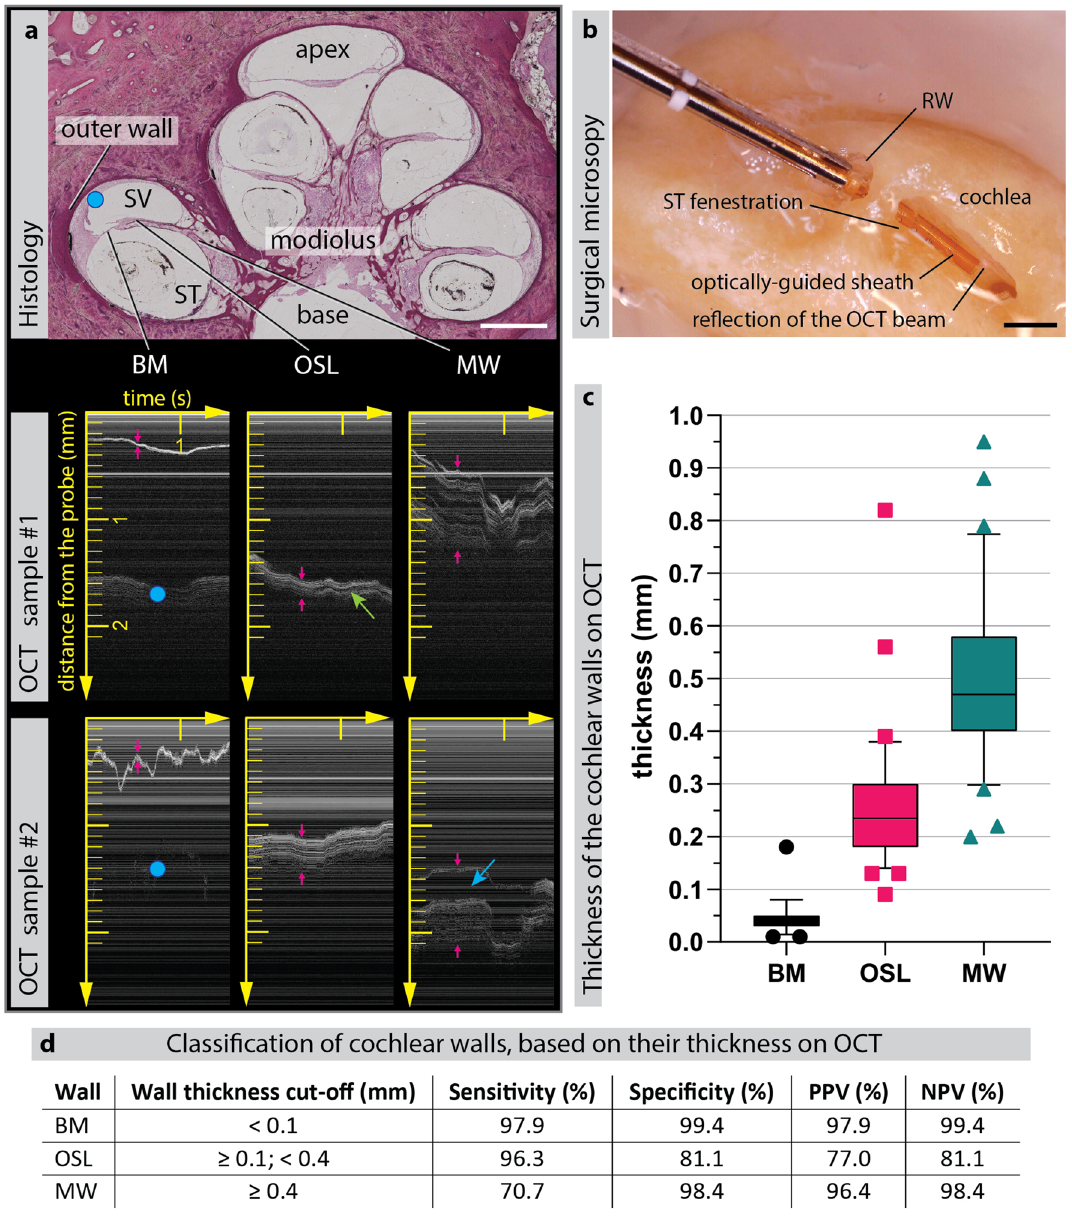
Figure 2. Thickness-based identification of the cochlear walls with the optically-guided sheath. ( a ) Histological section of a human cochlea is provided to illustrate the imaged cochlear walls, with indication of the cochlear apex, base, modiolus, the cochlear compartments (scala vestibuli and scala tympani) and the outer wall. Below, representative OCT M-scans of the BM, OSL and MW in samples #1 and #2 are shown, which were acquired by means of optically-guided sheath. The top of each OCT image corresponds to the position of the probe tip. Each OCT A-scan acquisition corresponds to a column of the OCT image, with a sequence of A-scans (M-scan) acquired over time as the probe is inserted and displayed left to right. The horizontal axis shows time in seconds (most recent A-scans appear on the right side of the M-scan) and the vertical axis shows distance from the probe in millimeters. Horizontal lines in OCT are due to additional back-reflections within the OCT system, which form a constant noise pattern. Red arrows indicate the thickness of the cochlear walls. The wall of the scala vestibuli can sometimes be visualized through the BM (blue dot). Green arrow indicates the gap between the two bony laminae of the OSL, visualized on OCT. Blue arrow indicates a large non-bony gap, presumably corresponding to the Rosenthal’s canal within the MW, which contains the auditory nerves. ( b ) Microscopic photograph of the optically-guided sheath inside the fenestrated ST of the sample #1, with visible reflection of the near-infrared OCT beam from the OSL cochlear wall ( c ) Box & whiskers graph, depicting OCT thickness of the three analyzed cochlear walls in samples #1 and #2 (n = 202 measurements: 47 BM, 80 OSL, 75 MW) with their respective median, interquartile range and 5–95 percentile. ( d ) The cut-offs of the thickness-based cochlear wall identification with their resulting sensitivity, specificity, positive predictive value (PPV) and negative predictive value (NPV). BM basilar membrane, MW modiolar wall, OSL osseous spiral lamina, RW round window, ST scala tympani, SV scala vestibuli. Scale bar: 1